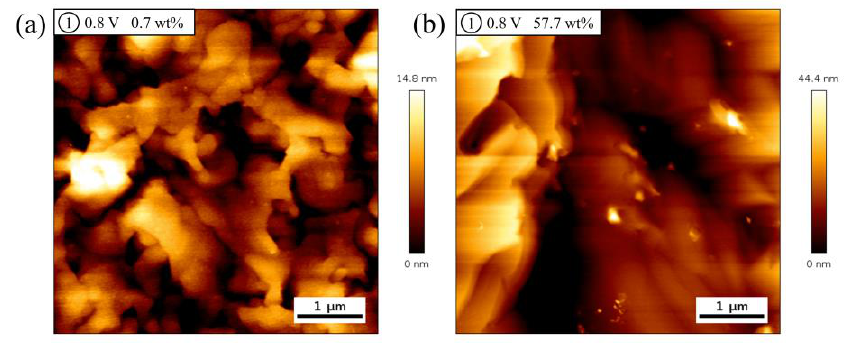
Figure 5. (a, b) AFM images of Au(111) electrode surface after holding at 0.8 V for 3 min in ethaline with water contents 0.7 wt% ( a ) and 57.7 wt% ( b ),